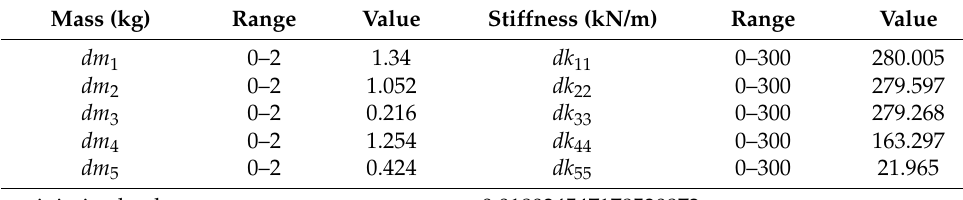
Figure 21. Modified structure after the addition of spring-mass substructures. Table 13. Parameters of added masses and stiffness of the substructures.